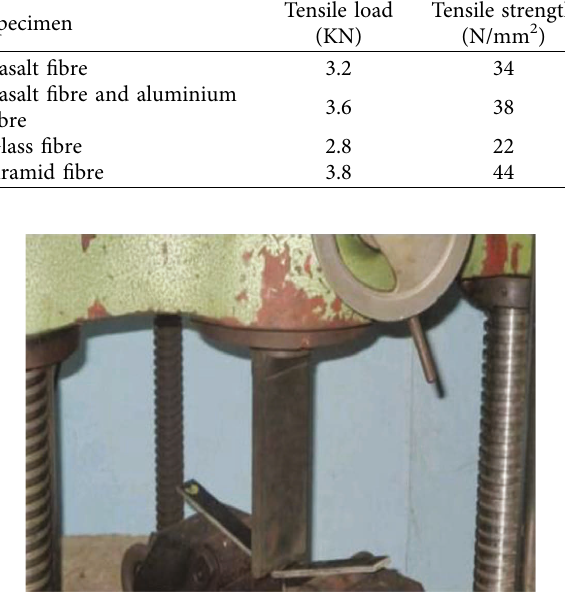
Figure 4: Flexural testing of the specimen